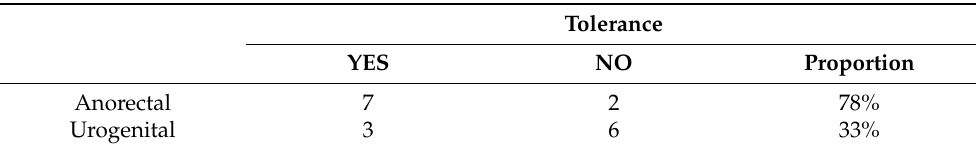
Table 1. Tolerance appearance (yes or no) in anorectal and urogenital clinical N. gonorrhoeae isolates, with corresponding